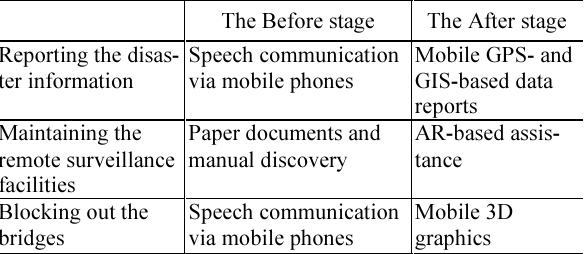
Table 2. The used methods in the Before and After stages The Before stage